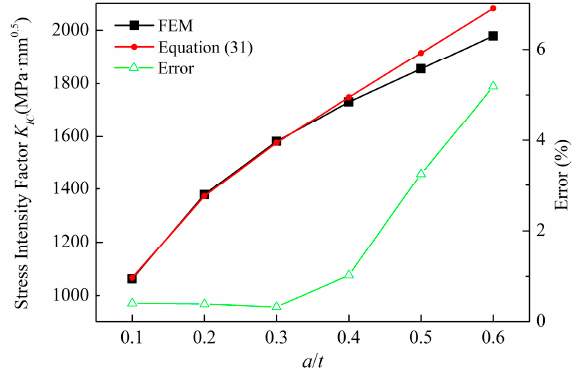
Figure 11. Comparison of stress intensity